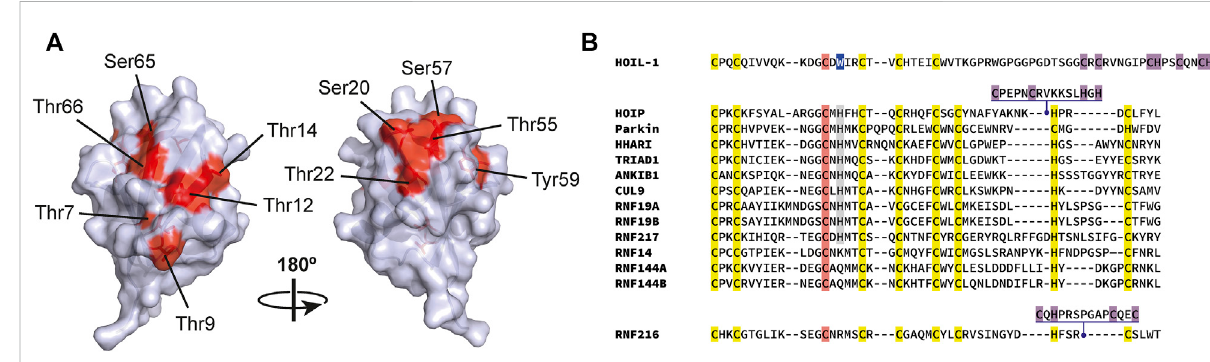
FIGURE 7 HOIL-1 catalyzes serine and threonine ubiquitylation. (A) Structure of ubiquitin (PDB: 1UBQ) (Vijay-Kumar et al., 1987) highlighting the eleven hydroxylated amino acids (shown in red). HOIL-1 can form ubiquitin dimers in vitro , with oxyester linkages at Thr12, Ser20, Thr22, and Thr55 all reported. Note that the last three of these residues cluster at a single region on the surface of ubiquitin. (B) Alignment of the human RBR domain sequences inthecatalyticRING2domain.Conservedzinccoordinatingresiduesthat formtheRING2fold arehighlightedyellow,theactive site cysteine is highlighted in red, the catalytic histidine residue present in most RBRs is highlighted in gray; in HOIL-1 this is a tryptophan and is highlighted in blue. Unique inserts exist in HOIL-1, HOIP, and RNF216, and putative or con fi rmed zinc coordinating residues are highlighted purple.